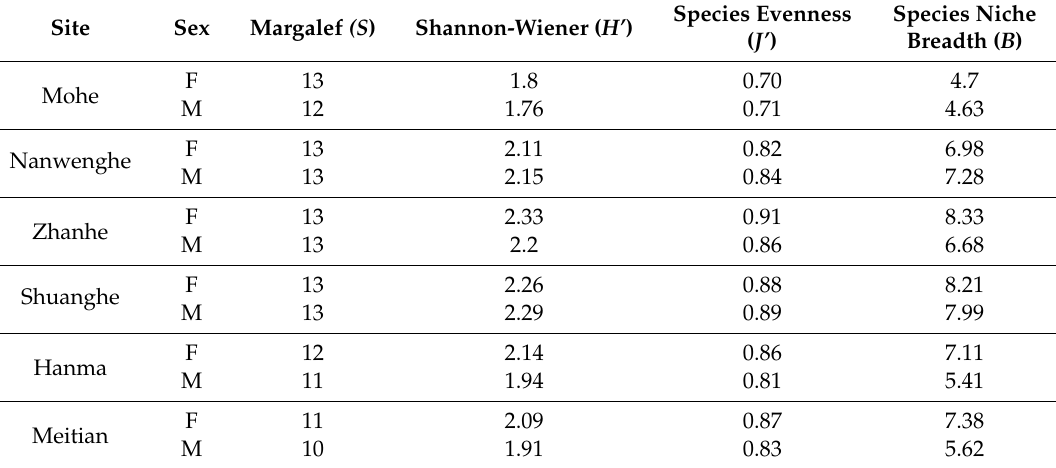
Table 2. Food species, diversity, evenness indices, and niche width of moose during winter.